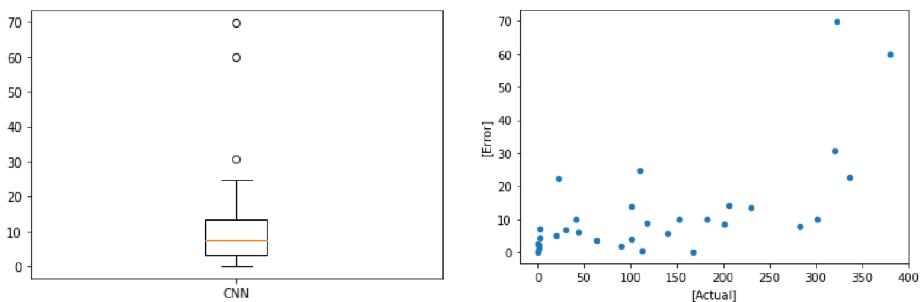
Figure 7. A boxplot and a scatterplot showing the results of our CNN-based regressor on the test set with transfer learning